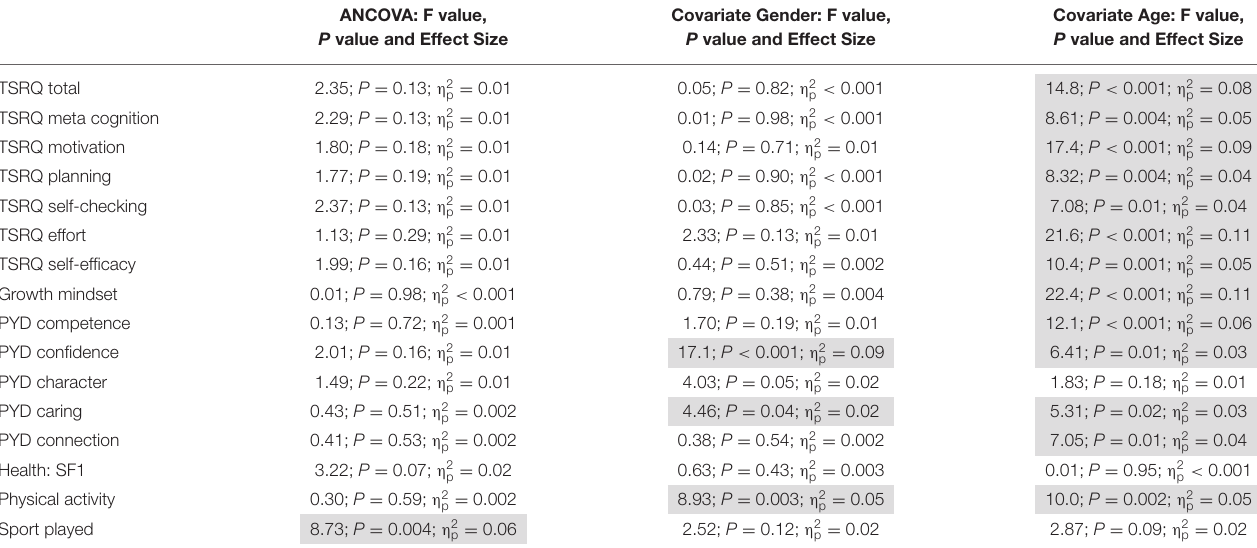
TABLE 4 | Results of the multivariate analysis of covariance (grey area indicate significant